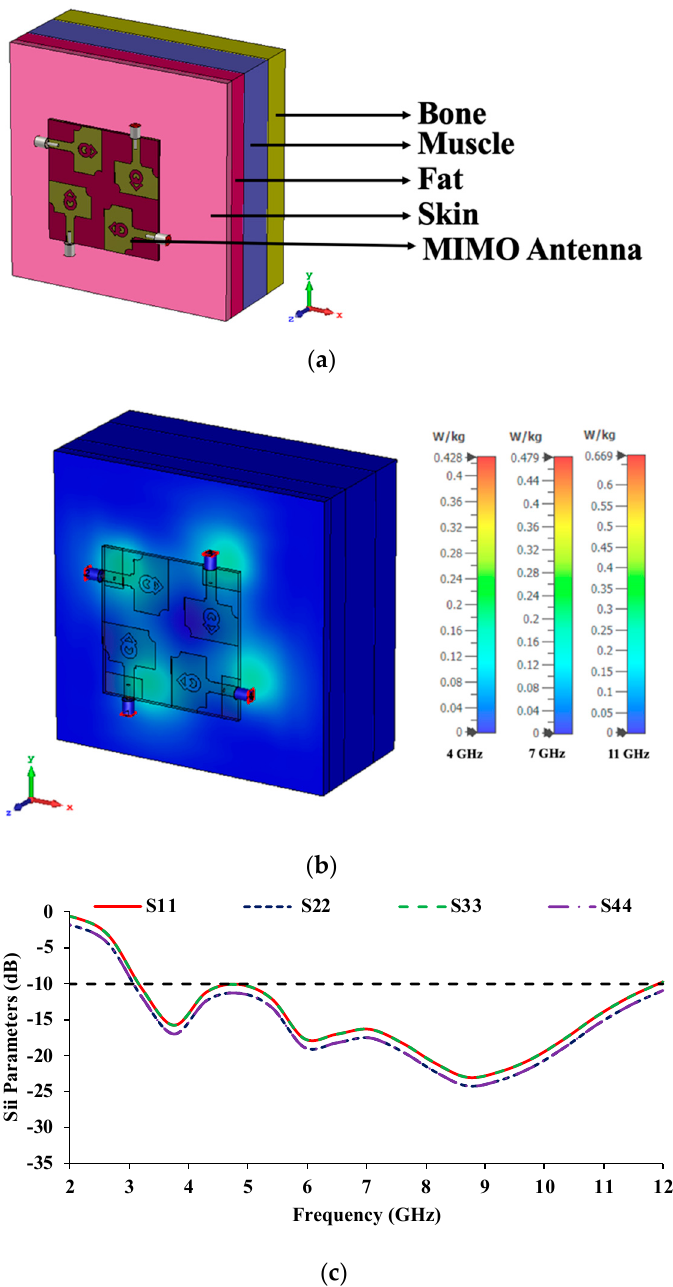
Figure 21. SAR analysis of the MIMO antenna ( a ) Simulated prototype, ( b ) SAR values, ( c ) Reflection coefficient curves.